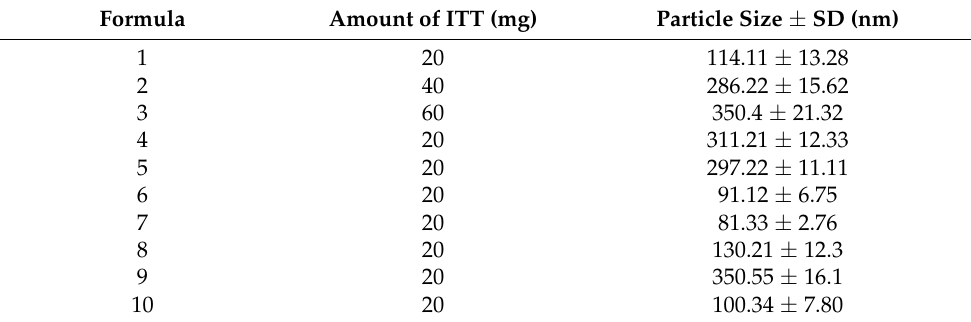
Table 4. Particle size and ITT content of different formulations prepared during pre-formulation step. Data are presented as mean ± SD ( n =